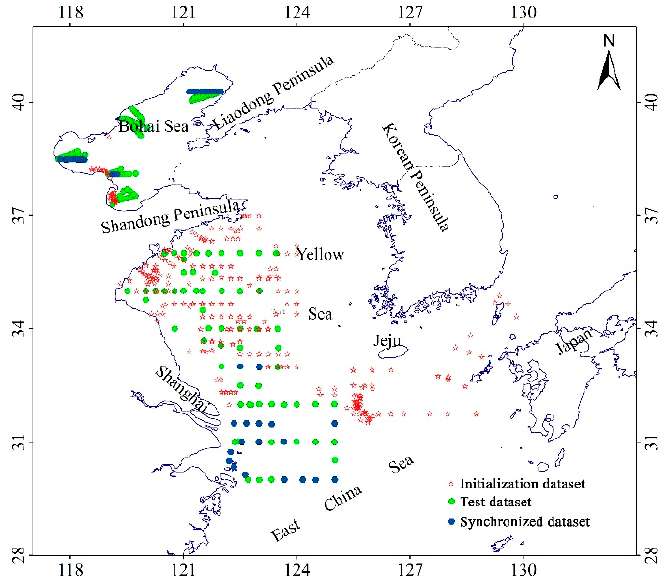
Figure 1. In situ data collected from China Eastern Coastal Zone (CECZ) Seas: the red stars are the spatial distribution of initialization dataset; the green circles are the spatial distribution of the testing dataset; and the blue circles are the spatial distribution of the synchronized dataset.